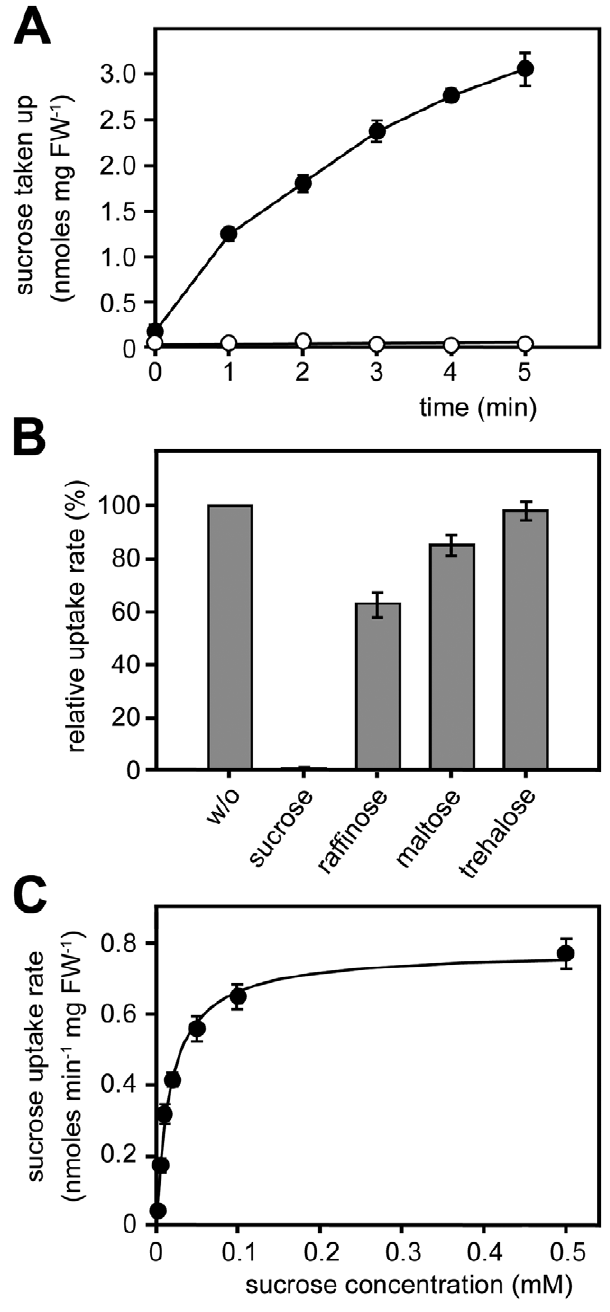
Figure 5. Srt1-dependent 14 C-sucrose uptake in S.cerevisiae . (A) Uptake of 14 C-sucrose by srt1 -expressing (closed circles) and control cells (open circles). (B) Competition analysis (0.1 mM 14 C-sucrose) with different potential substrates added at 100-fold molar excess. w/o, without. (C) Michaelis-Menten kinetics of sucrose uptake rates (pH 5.0) indicate a K M of 26 6 4.3 m M (standard error [SE]). Error bars represent SE ( n =3). doi:10.1371/journal.pbio.1000303.g005 data demonstrate that the uptake of sucrose by Srt1 is not a possible side activity of this protein, but rather its only and exclusive function. They also show that Srt1 is a novel fungal sucrose transporter and that its activity is essential to develop full virulence of U. maydis .